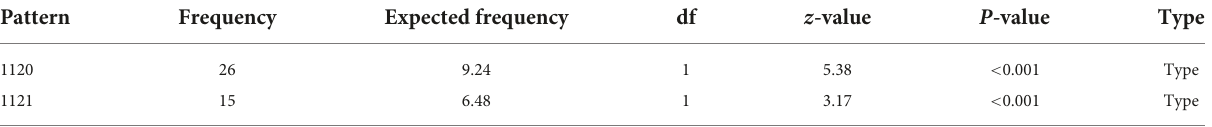
TABLE 2 Configural frequency analysis patterns emerging as